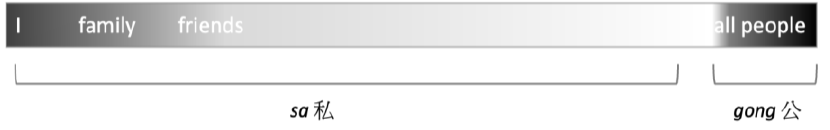
Figure 1. Diagram of gong and sa.